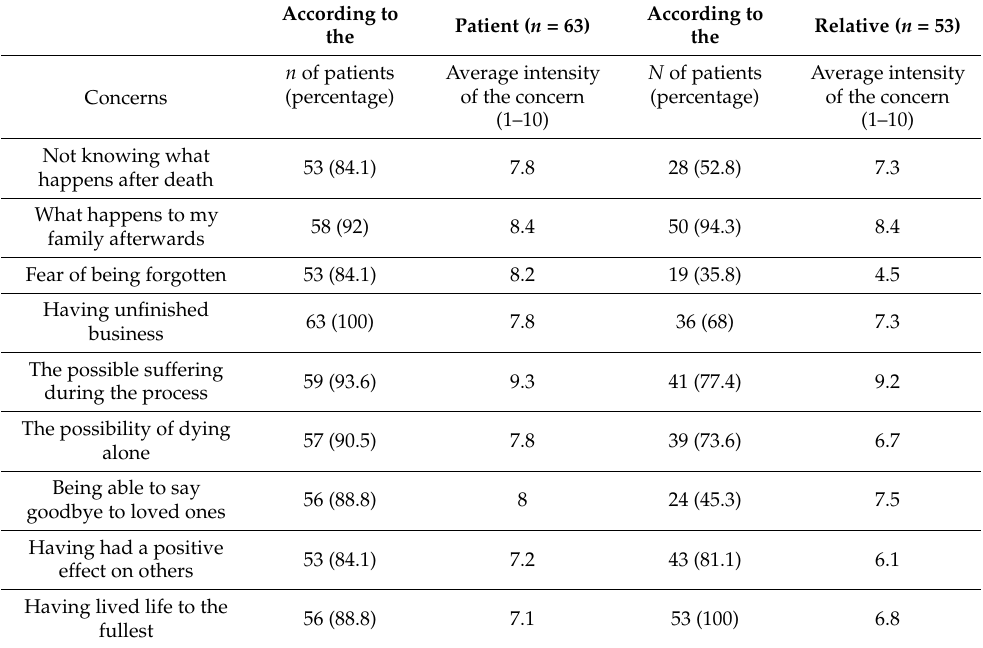
Table 2. Answers obtained in the questionnaire of the patient’s concerns (according to the patient and the relative).